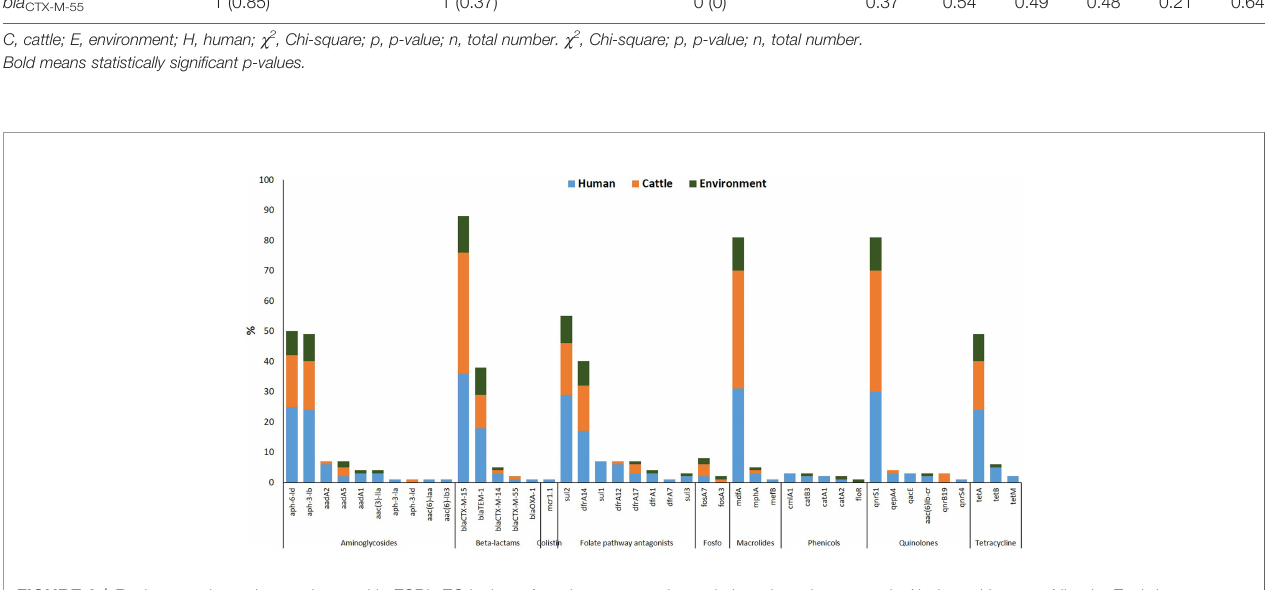
FIGURE 2 | Resistance determinants detected in ESBL-EC isolates from humans, cattle, and abattoir environments in Abuja and Lagos — Nigeria. Each bar represents the various antimicrobial-resistant genes detected in ESBL-EC isolates obtained from abattoir workers, beef cattle, and abattoir environments.